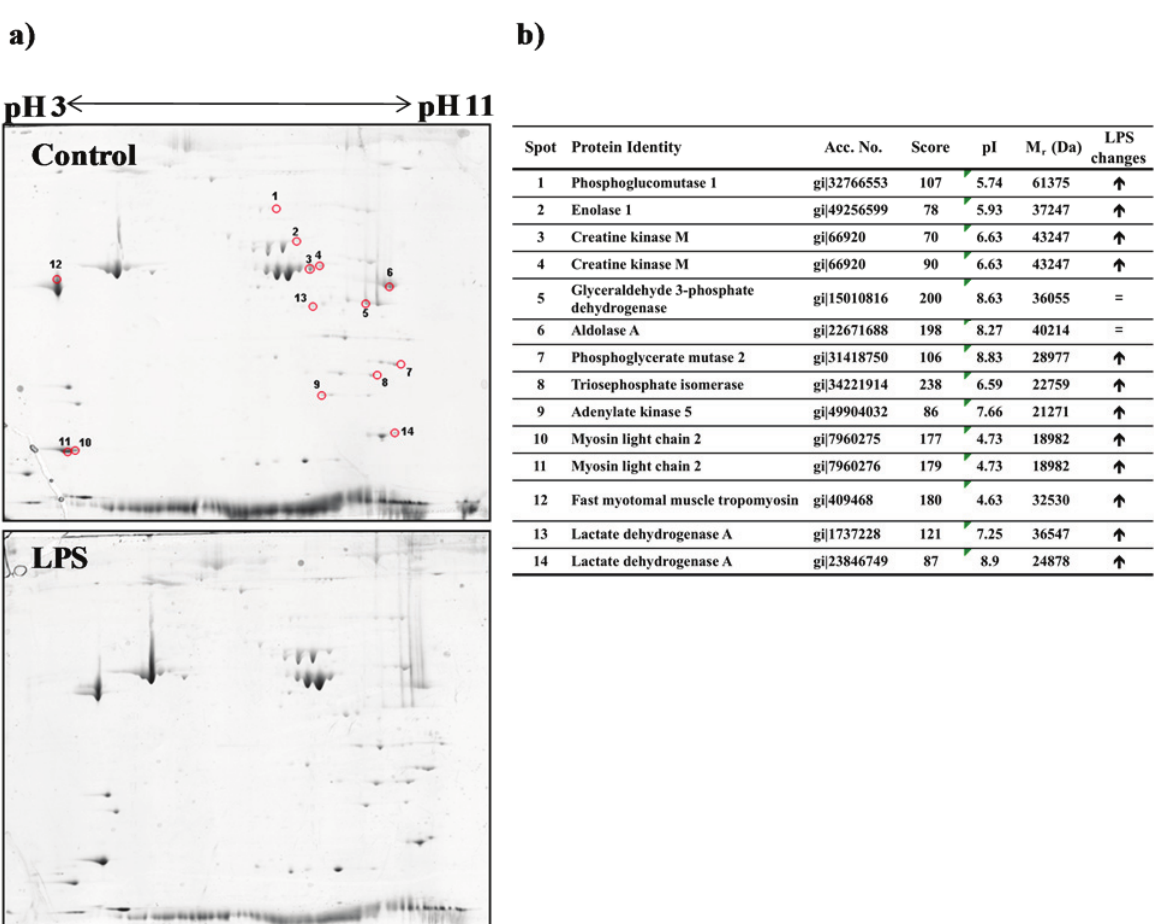
Figure 5. Proteomic changes in trout fast skeletal muscle after lipopolysaccharide (LPS) administration. ( a ) Representative bi-dimensional Coomassie stained 2-DE gels of pooled fast skeletal muscle samples from trout injected with saline (Control; n = 3) or LPS ( n = 3), performed in triplicate. In the control gel, the spots circled in red indicate proteins identified by MALDI/TOF; ( b ) Identification of proteins separated by 2-DE. Database accession numbers are indicated as a GI number. MASCOT score greater than 72 indicates that the protein identification is significant ( p < 0.05). The qualitative direction of change of identified proteins in LPS versus control gels is indicated by arrows. = indicates absence of visual changes in spot